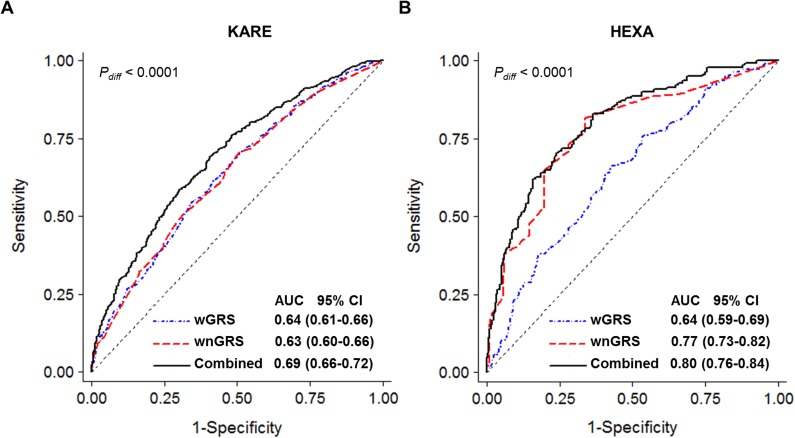
Comparison of predictability of risk prediction models for tuberculosis in KARE (463 cases and 1,308 controls) (A) and HEXA (142 cases and 490 controls) (B) Studies. wGRS comprised of ten SNPs replicated in both studies (blue-dotted line), wnGRS comprised of six nongenetic factors, age, sex, body mass index (< 20 kg/m2), systolic blood pressure (120 mmHg <), hemoglobin, cigarette smoking (red dashed lines), and the combined model of wGRS and wnGRS (solid black lines).